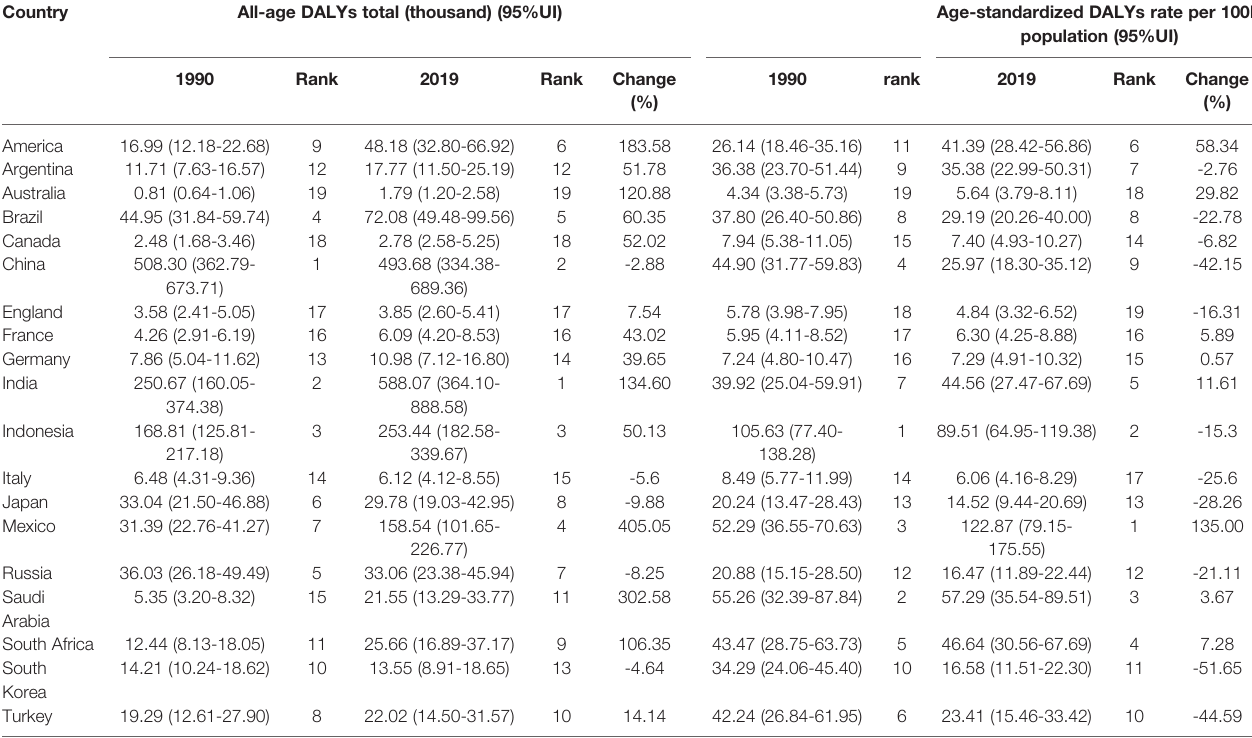
TABLE 1 | All-age DALYs and age-standardized DALYs rate (per 100,000 population) for T1DM-related CKD in 1990 and 2019 among the G20 countries (the 20th member is the European Union). Country All-age DALYs total (thousand)